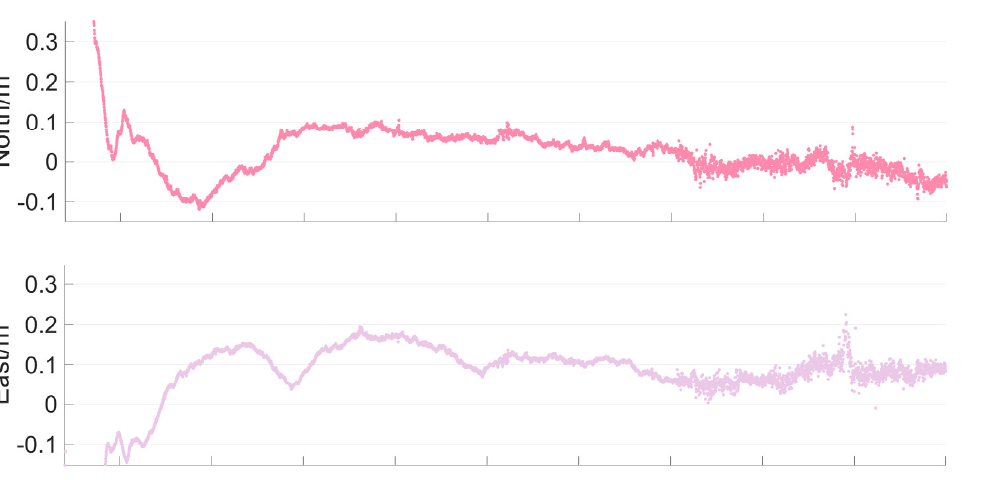
Figure 15. Real-time PPP-B2b positioning accuracy in kinematic mode, including PPP-B2b service interruptions. 4. Discussion The introduction of the PPP-B2b service offers a new possibility for real-time posi- tioning. To achieve real-time precise positioning, it is necessary to have access to continu- ously available, reliable, and accurate orbits and clocks products [23]. The PPP-B2b service requires that GEO satellites be visible, but in urban environments, these satellites may be blocked by the “south wall effect” or “north wall effect” for short periods, preventing us- ers from receiving continuous precise orbits and clocks, which significantly impacts real- time positioning results. Therefore, it is important to consider strategies for maintaining real-time positioning during short interruptions of the PPP-B2b service when using this service. In this study, the characteristics of the PPP-B2b corrections during DOY 192–198 in 2022 were analyzed. The results demonstrate that the PPP-B2b corrections were subject to frequent jumps due to broadcast ephemeris updates and other factors. Specifically, the orbit corrections for the BDS-3 MEO, BDS-3 IGSO, and GPS satellites jumped on average 11, 26, and 17 times per day, respectively. Similarly, the clock corrections jumped on av- erage 11 and 33 times per day for BDS-3 and GPS satellites, respectively. These jumps can make the data set used for predicting discontinuous, and can significantly affect the pre- dictability of the PPP-B2b corrections. Several studies have demonstrated that combining corrections with broadcast ephemerides can improve continuity, which is also beneficial for predicting continuous periods [19–21]. However, systematic jumps and errors still oc- cur for the PPP-B2b precision ephemerides. When a break occurs at the next ephemeris